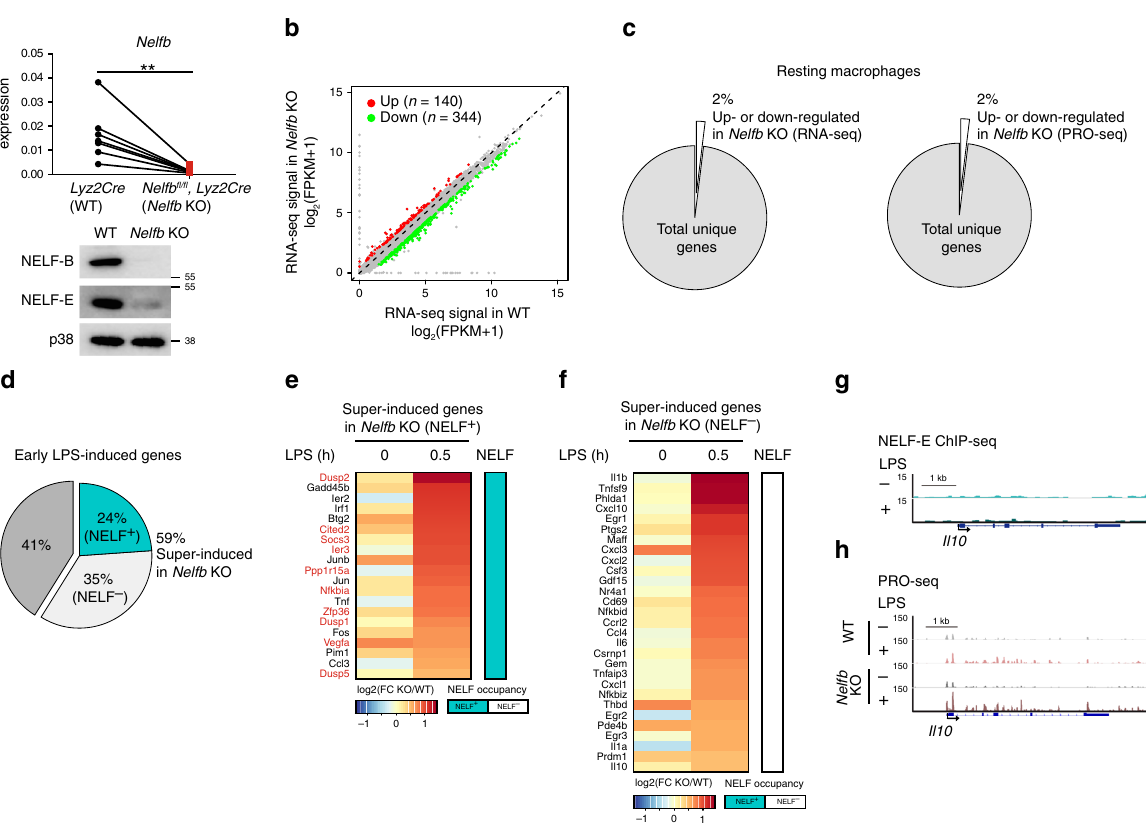
Fig. 5 NELF regulates early inducible transcription activation in macrophages. a Assessment of Nelfb KO ef fi ciency. Nelfb mRNA (top) was measured by RT-qPCR in BMDM from multiple Lyz2Cre (WT) and Nelfb fl / fl , Lyz2Cre ( Nelfb KO) mice ( n = 7) ( P = 0.0066); ** P < 0.01 by two-sided paired Student ’ s t test. Wes t ern blot (bottom) analysis for NELF-B, NELF-E, and p38 in resting BMDM from WT and Nelfb KO mice. b Differentially expressed genes in resting macrophages assessed by RNA-seq. x - and y -axes correspond to normalized RNA-seq counts (FPKM) for total unique genes in WT and Nelfb KO BMDM, respectively. Upregulated and downregulated genes are highlighted in red and green, respectively. c The per c entage of up- or down-regulated genes assessed by RNA-seq (left) and PRO-seq (right) in resting Nelfb KO BMDM compared to WT among total unique genes. d The percentage of genes super-induced in Nelfb KO BMDM among early (0.5 h) LPS-induced genes ( n = 83). e , f Heat maps show the RNA-seq expression level (FPKM + 1) fold changes ( Nelfb KO/WT) of NELF + ( e ) and NELF − ( f ) genes super-induced in Nelfb KO in resting and LPS-treated (0.5 h) BMDM. Anti-in fl ammatory genes in ( e ) are shown in red. g NELF-E ChIP-seq tracks are shown for the Il10 locus in resting ( − ) and LPS-activated (0.5 h) ( + ) BMDM. h PRO-seq (sense strand) tracks for the Il10 locus in WT and Nelfb KO are shown for resting ( − ) or LPS-stimulated (0.5 h) ( + ) BMDM. Source data are provided as a Source Data fi